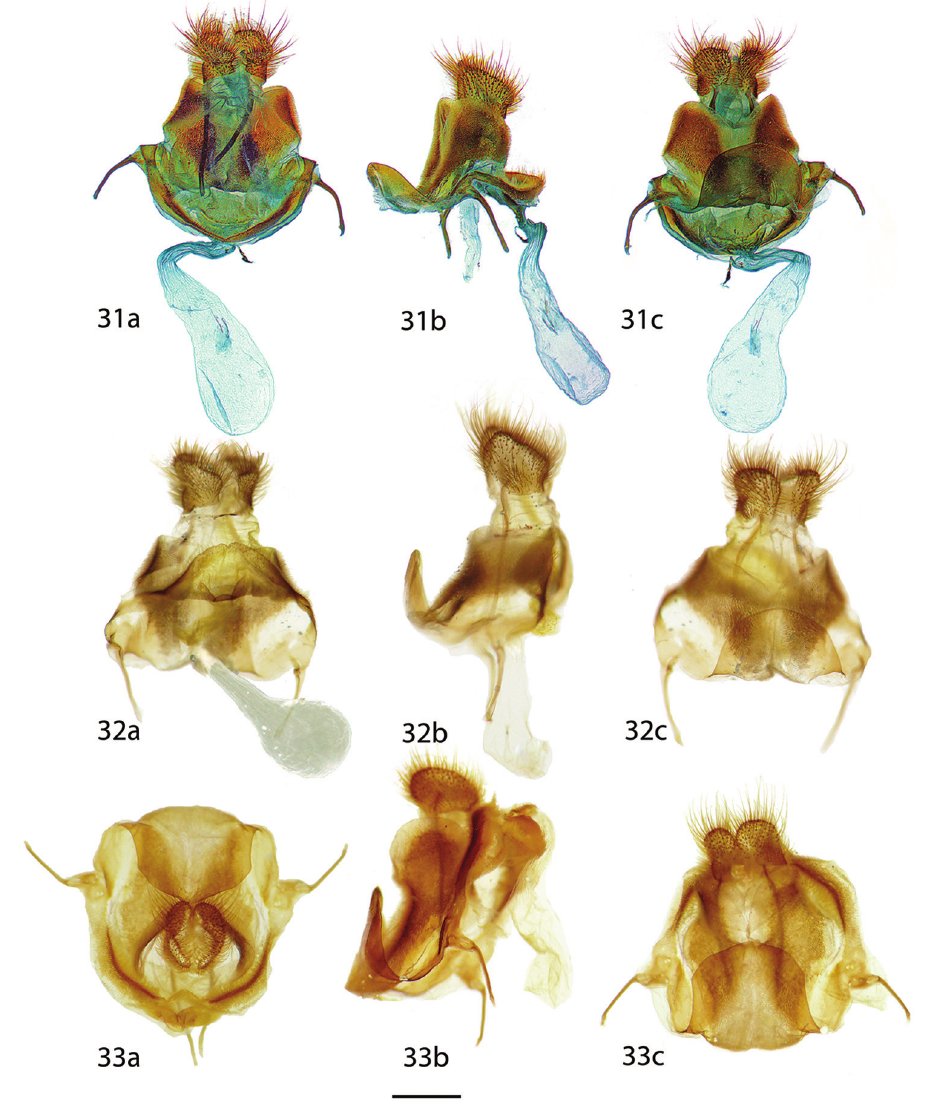
Figures 31–33. Reinmara female genitalia, a ventral b lateral c dorsal. 31 R. enthona , French Guiana, Kaw Rd., PK 37.5 + 2, 200 m, D. Herbin genitalia prep. H. 1103 (CDH) 32 R. wolfei , Brazil, Distrito Federal, Planaltina, 1000 m, C. Mielke genitalia prep. 6.879 (CPAC) 33 R. minasa , Brazil, São Paulo, Santo